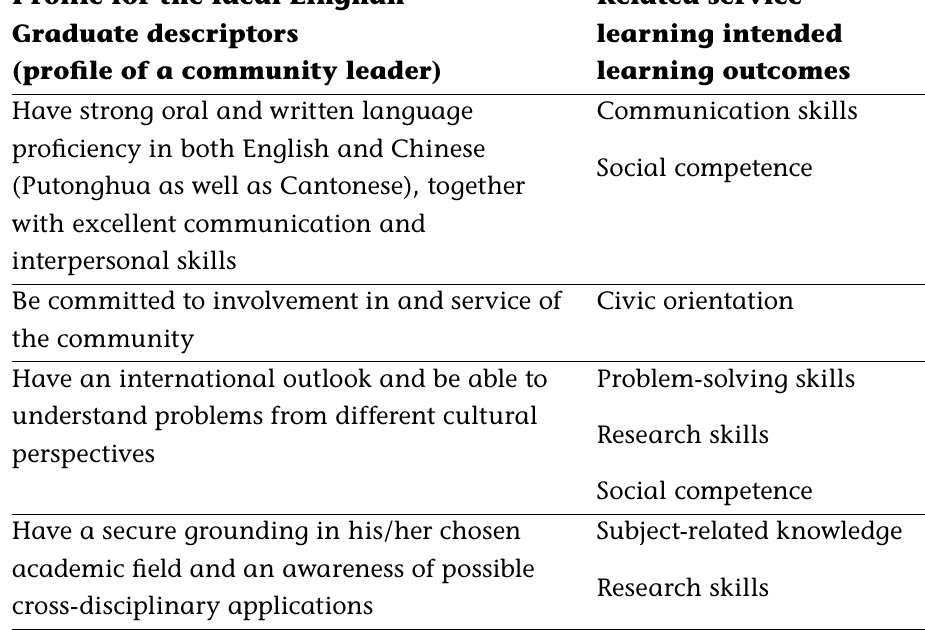
Table 2: How S-L intended learning outcomes relate to the ‘Profile for the Ideal Lingnan